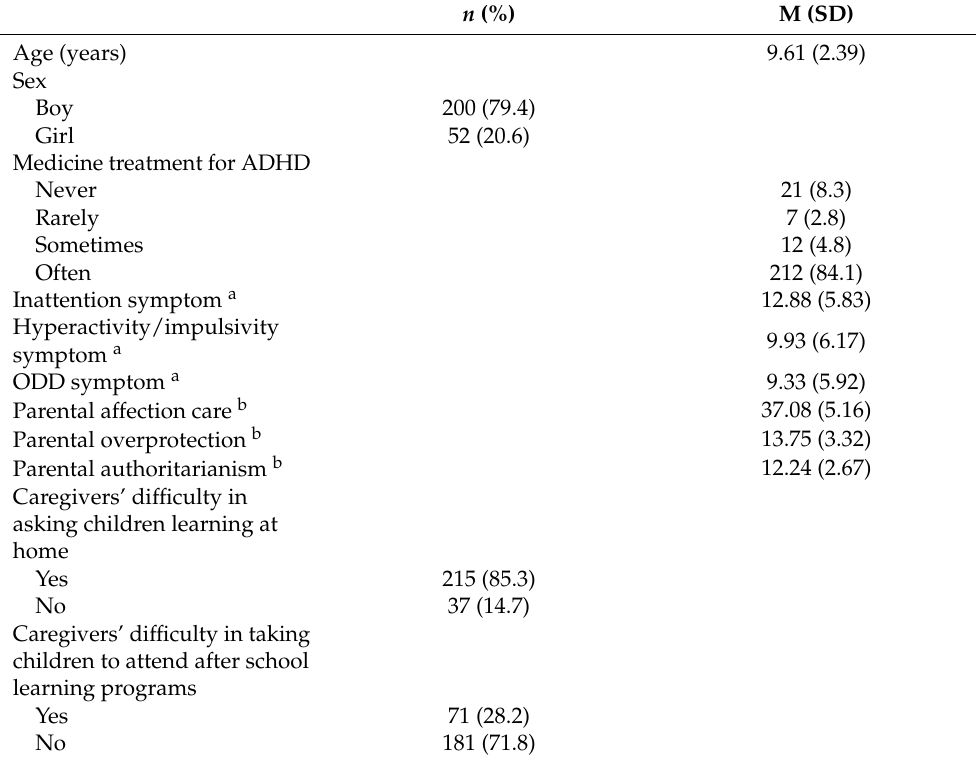
Table 1. Characteristics of the participants and caregivers’ difficulties in managing ADHD children’s learning (N =